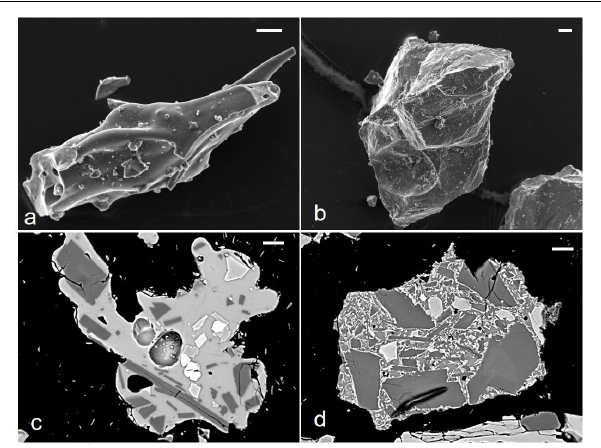
FIGURE 2 | Secondary (top) and backscattered (bottom) scanning electron microscope images of typical sideromelane (a,c) and tachylite (b,d) ash particles at Mount Etna. Scale bar 20 µ m in all